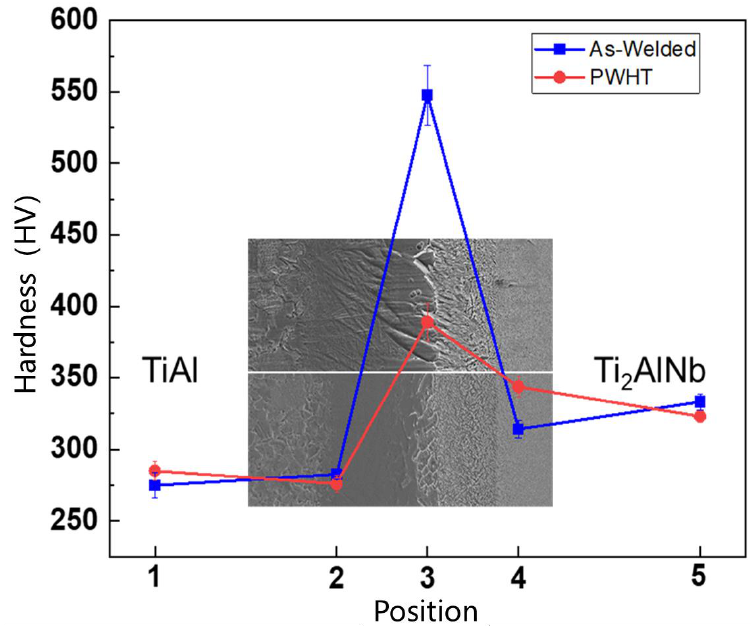
Figure 7. Microhardness test results of the TiAl/Ti 2 AlNb SPDB joint.